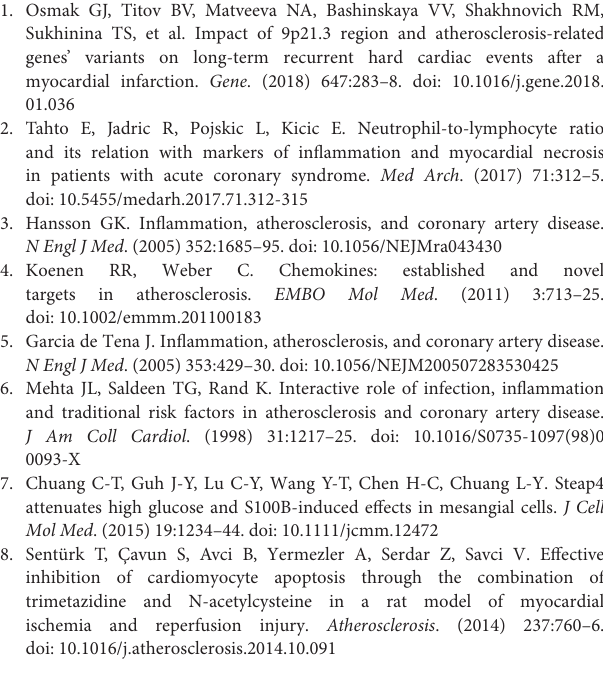
FIGURE 5 | analysis of mRNA level of RAGE–NF κ B–IL1 β /IL6 in neutrophils with S100B, sicontrol and siRAGE. (E) Untransfected or transfected neutrophils with a control siRNA vector or siRAGE to enable the overexpression of the S100B fusion protein, control siRNA, or siRAGE were subjected to the transwell chamber migration assay. Cells that had migrated to the lower surface of the transwell chamber were stained with crystal violet and counted under a microscope. Representative microscopic images are shown. The column chart shows mean numbers of migrated cells in three